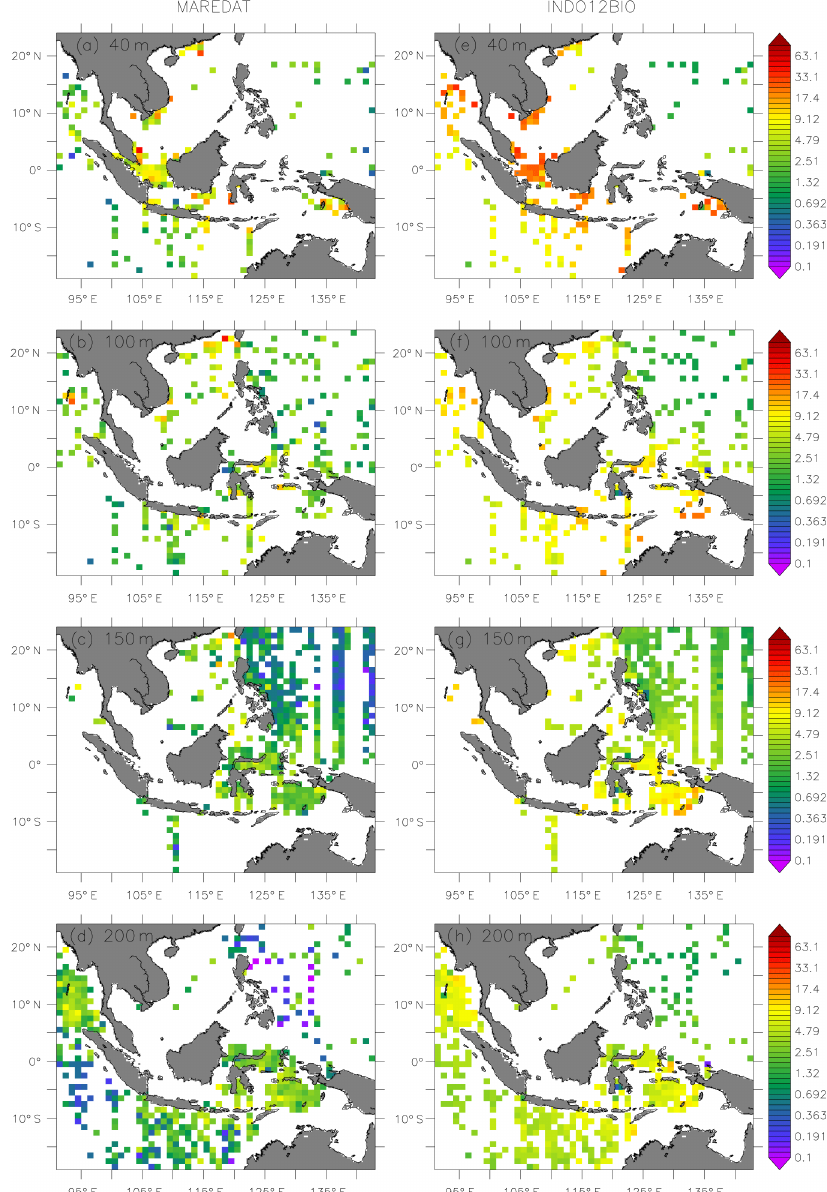
Figure 6. Annual mean of mesozooplankton biomass (µgCL − 1 ) from MAREDAT monthly climatology (left) and from INDO12BIO simu- lation averaged between 2010 and 2014 (right), for distinct depth interval: from the surface up to 40m (a, e) , 100m (b, f) , 150m (c, g) , and 200m depth (d, h) . Simulated fields were interpolated onto the MAREDAT grid, and masked as a function of the data (in space and